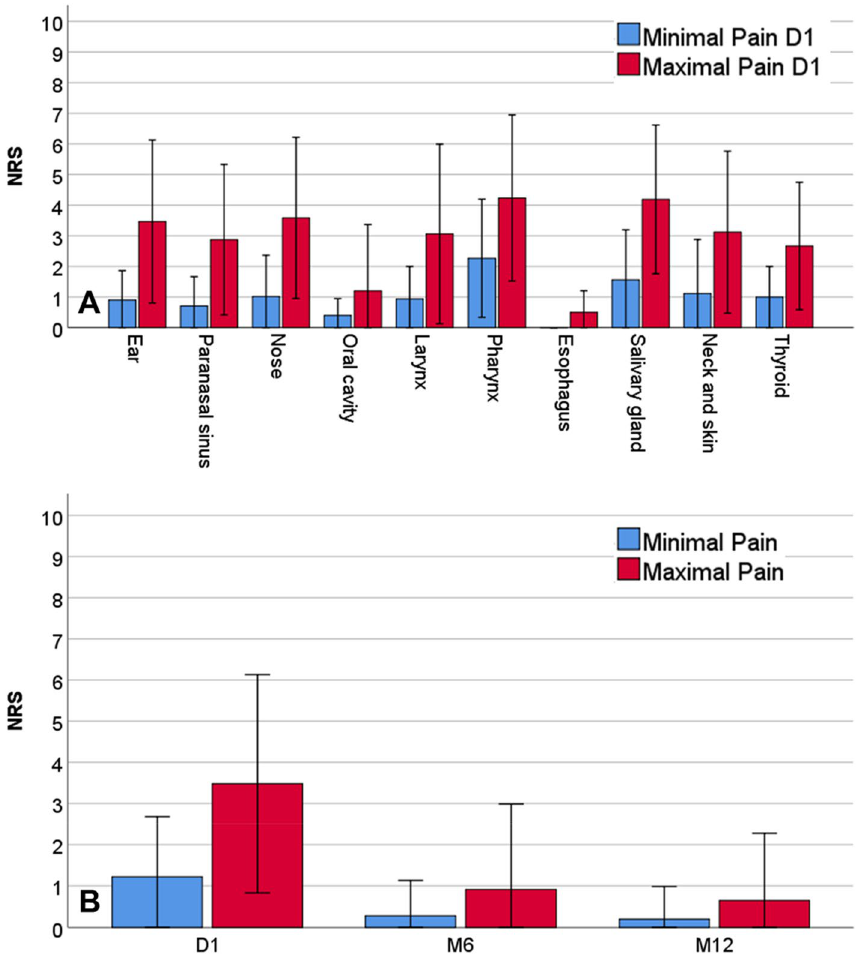
Figure 1. Average minimal and maximal pain at the first operative day (D1), after six months (M6), and after 12 months (M12). A : Pain at D1 for the different surgical groups. B : Comparison between D1, M6 and M12. NRS = numeric rating